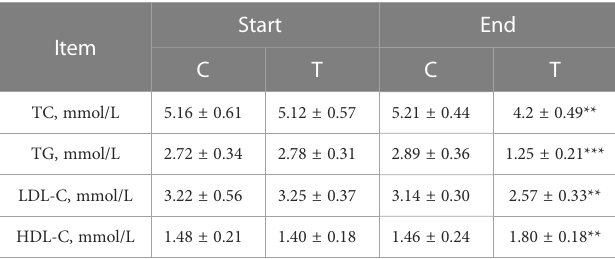
TABLE 2 Changes of the serum lipid metabolism parameters.